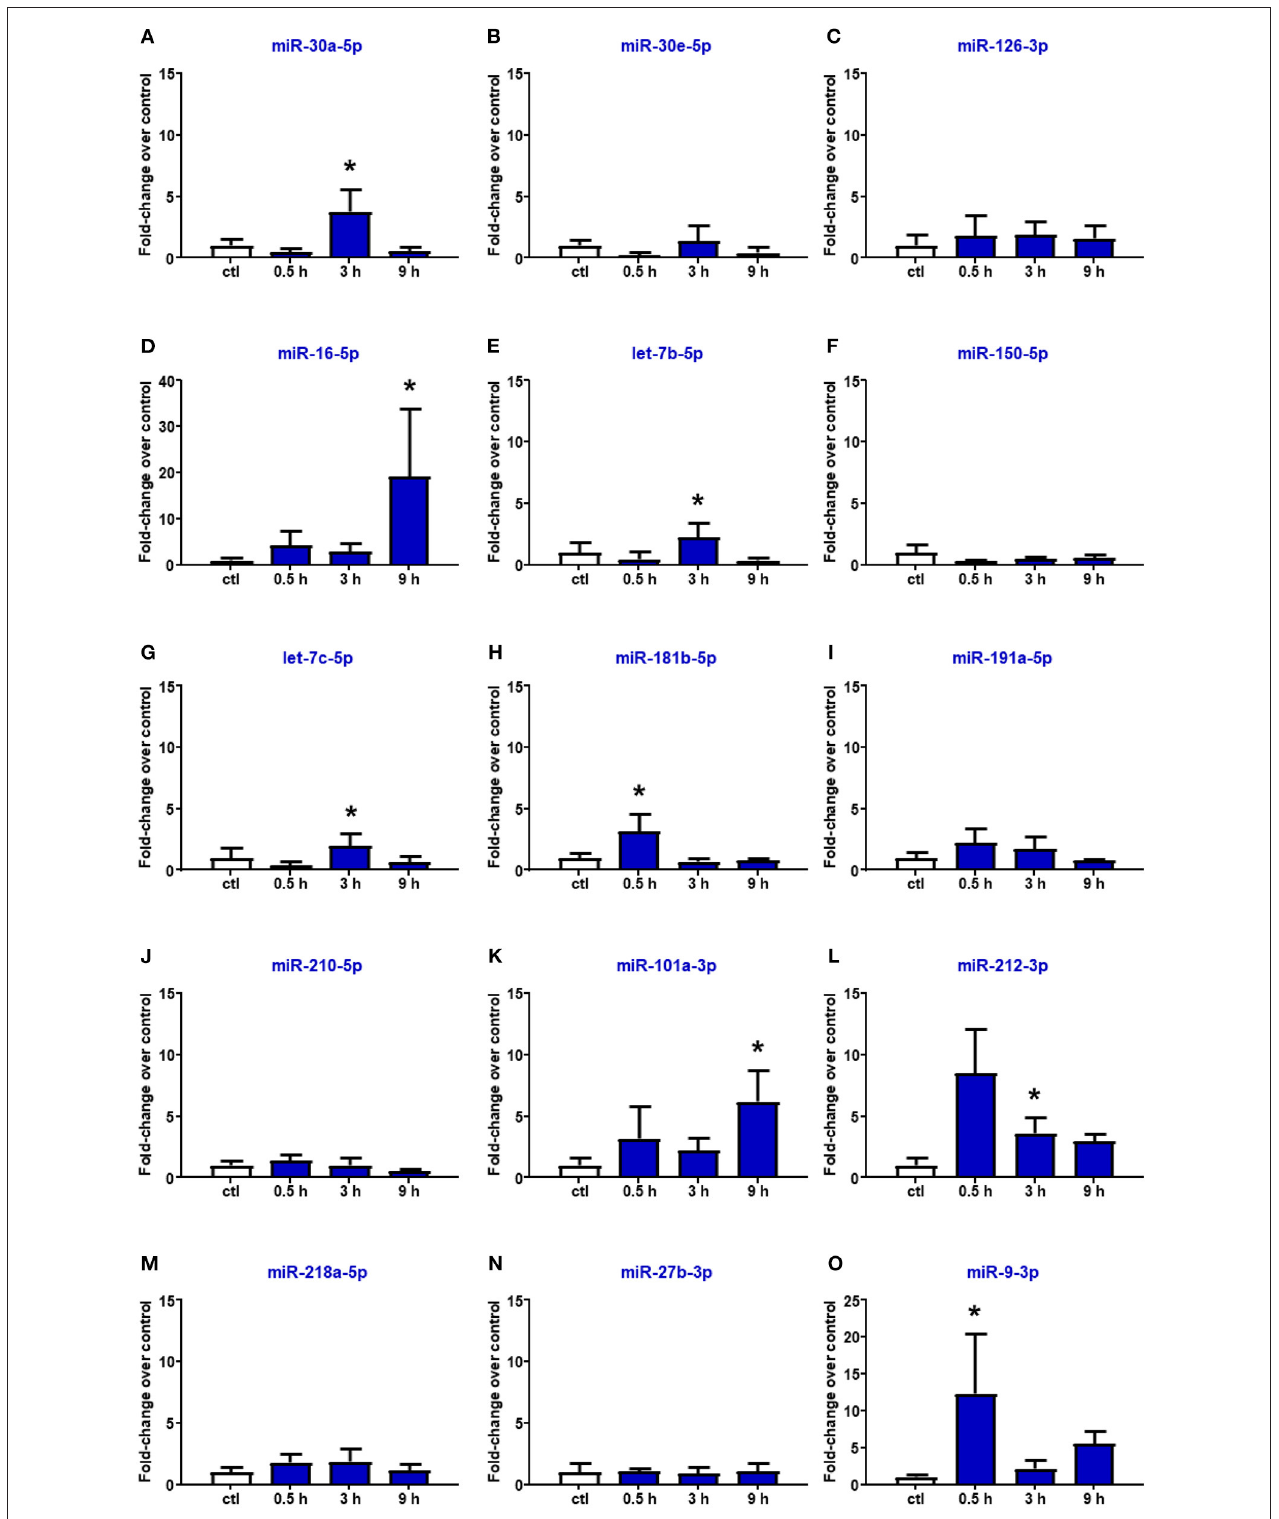
FIGURE 4 | Plasma microRNA expression analysis after transient middle cerebral artery occlusion by real-time PCR. microRNA levels analyzed by real-time PCR in plasma samples withdrawn from the tail vein of rats subjected to tMCAO are expressed as fold change over the control group. (A–O) indicate miRNAs evaluated. Each column represents the mean ± SD. The results of the microRNA expression were normalized with respect to U6 snRNA as internal control. n = 4 or 5 per group. * p < 0.05 vs. control group.